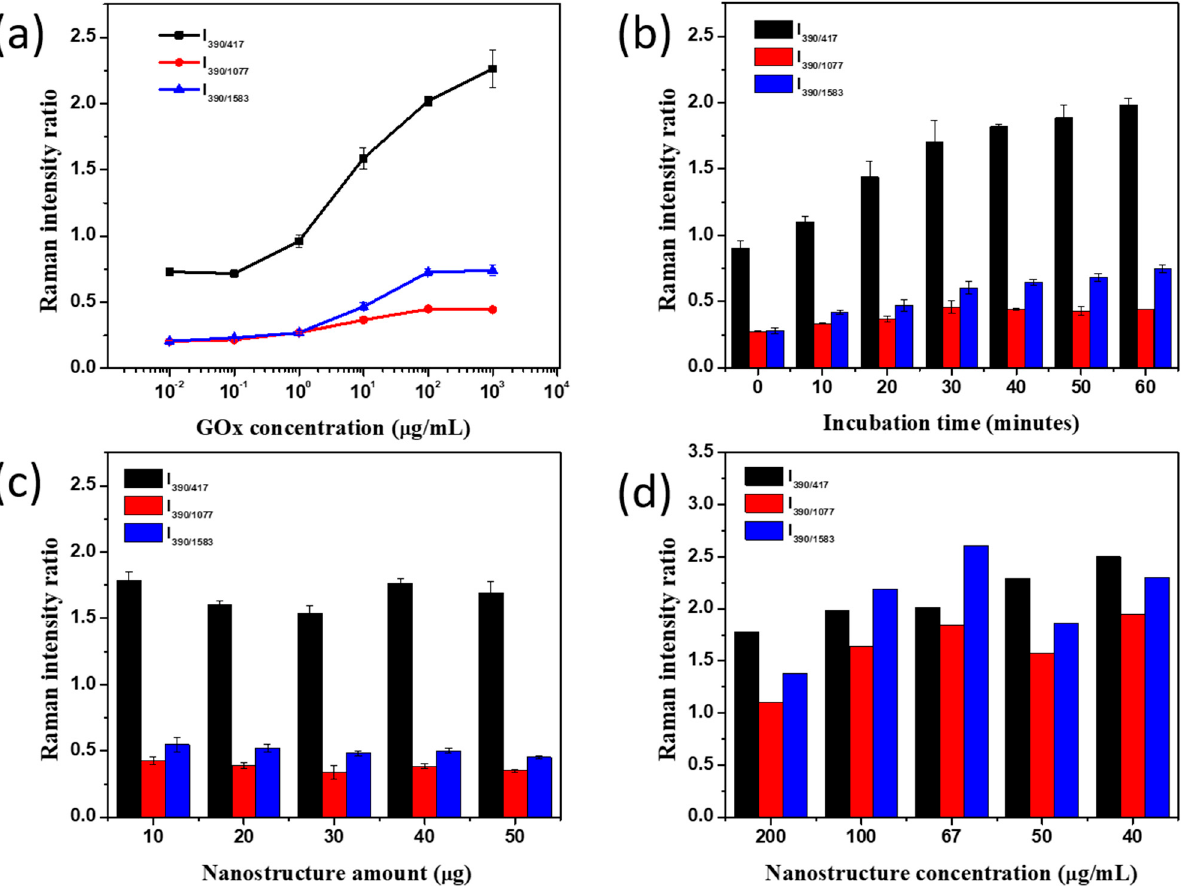
Figure 4. Optimization of glucose detection by SiO 2 @Au@Au@4-MPBA in all-in-one technique, ( a ) glucose oxidase concentration, ( b ) incubation time, ( c ) SiO 2 @Au@Ag@4-MBA amount, and ( d ) dilution of SiO 2 @Au@Ag for Raman measurement in PBST at I 390/417 , I 390/1077 , I 390/1583 .